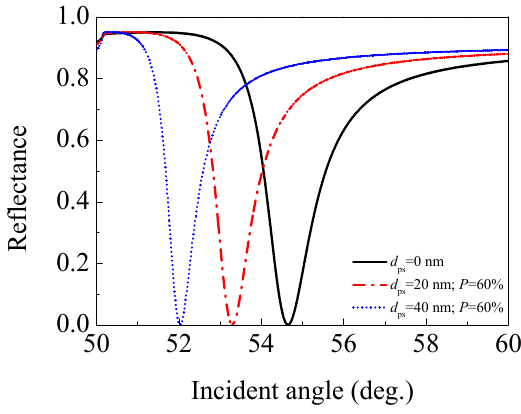
Figure 6. The angular spectra of the SPR sensors with 0 (traditional SPR sensor), 20, and 40 nm thick 60% porosity porous silica film ( n ps = 1.176). Table 3. The performance parameters of the SPR sensors with 0 (traditional SPR sensor), 20, and 40 nm thick 60% porosity porous silica film ( n ps = 1.176).